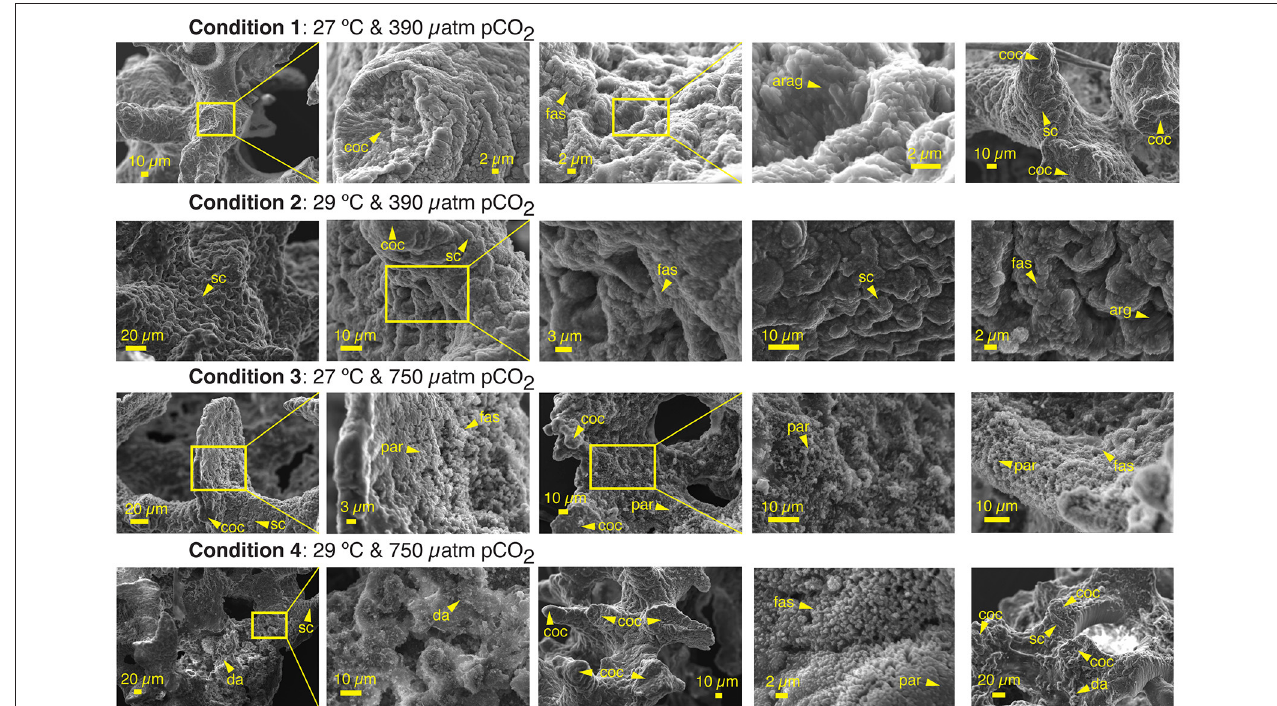
FIGURE 4 | High magnification Scanning Electron Microscopy results of primary polyp A. millepora juvenile corals. Each row of images is grouped by experimental condition, which are stated above the row and shown from left to right. Every image is a distinct A. millepora primary polyp that has been analyzed by laser ablation for this study. Skeletal microstructure features such as clear centers of calcification ( coc ) and fasciculi bundles ( fas ) composed of primary aragonite crystals ( arag ) can be seen throughout all four experimental conditions. The primary aragonite crystals ( arag ) of the primary polyps are predominantly orientated in a scale-like aragonite formation ( sc ) with newer growth layering on top of older growth. Less developed proto-aragonite ( par ) shingles prior to fine crystals development and presence of disorganized aragonite ( da ) are more prevalent in the OA conditions.